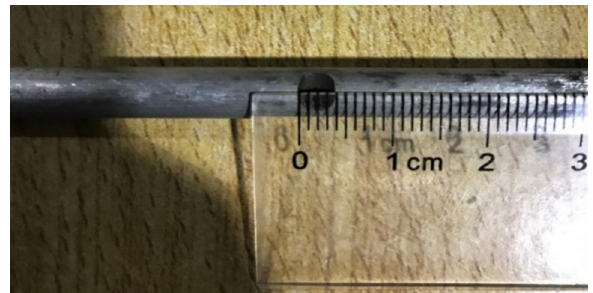
Figure 2. Photo of steel wire specimen with machine-cut notch.